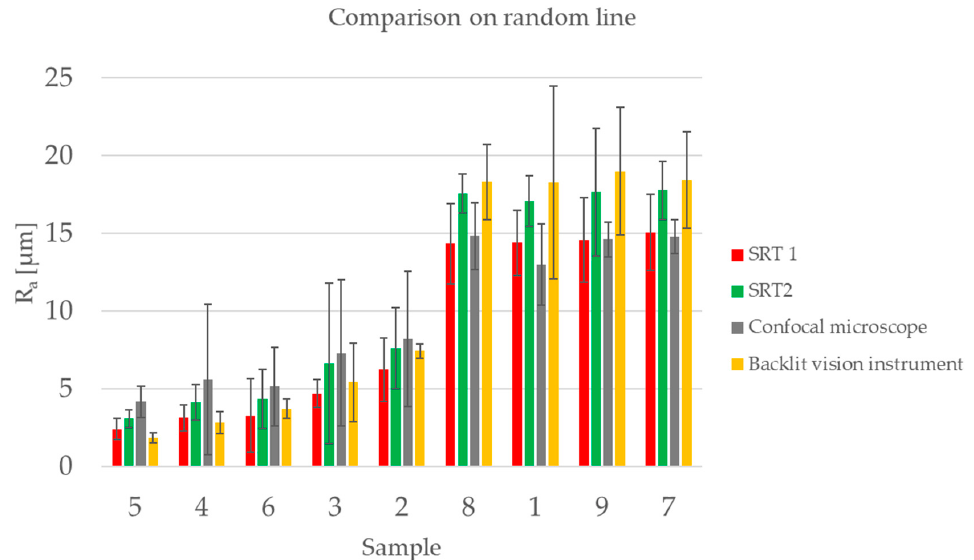
Figure 12. Overview of the results obtained by comparing the instruments on measurements per- formed on a random line on the surface. The samples are plotted in an increasing order of surface roughness of the reference instruments SRT 1. The error bar represents two times the range of the repeated measurements for each sample and each